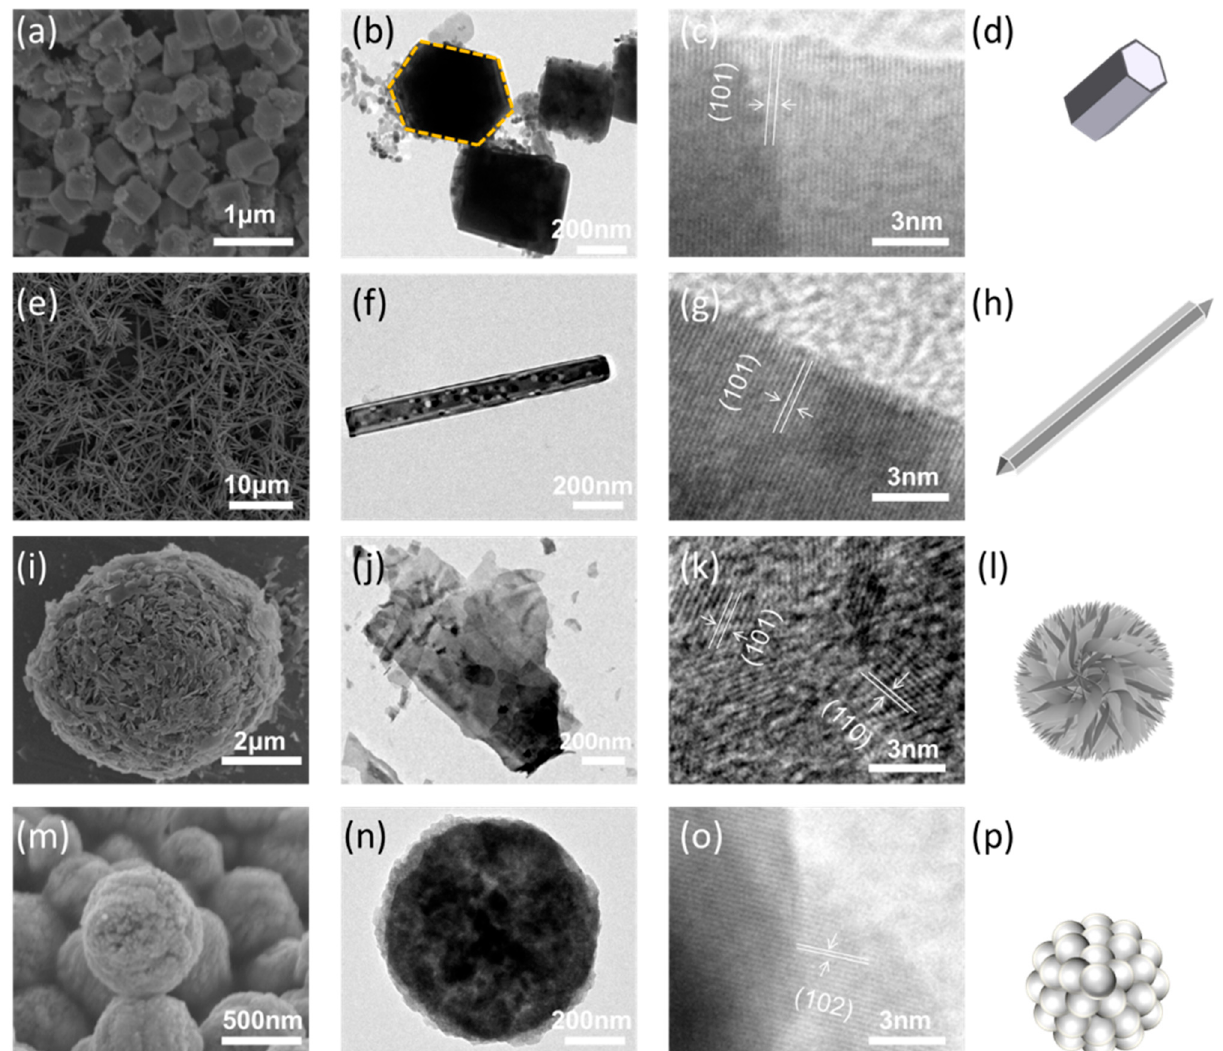
Figure 2. ( a ) SEM, ( b ) TEM, ( c ) HRTEM images, and ( d ) morphology schematic of ZnO short nanorods. ( e ) SEM, ( f ) TEM, ( g ) HRTEM images, and ( h ) morphology schematic of ZnO nanowires. ( i ) SEM, ( j ) TEM, ( k ) HRTEM images, and ( l ) morphology schematic of ZnO nanoflakes. ( m ) SEM, ( n ) TEM, ( o ) HRTEM images, and ( p ) morphology schematic of ZnO nanospheres. XPS spectra were analyzed to reveal the chemical binding states of elements in the ZnO samples (Figure 3). For the ZnO short nanorod sample, Zn 2p XPS spectra displayed two distinct peaks located at 1021.7 and 1044.75 eV, corresponding to the 2p 3/2 and 2p 1/2 doublets of Zn 2+ (see Figure 3a) [47]. O 1s XPS spectra could be deconvoluted into two peaks at 530.37 and 531.72 eV, which can be indexed to Zn-O and hydroxyl oxygen on the sample surface [48], respectively (see Figure 3b). The other ZnO samples with different morphologies (nanowires, nanoflakes, and nanospheres) showed similar Zn 2p and O 1s XPS spectra to the ZnO short nanorods (see Figures 3c–h), indicating that these four ZnO samples have similar chemical states of Zn and O.